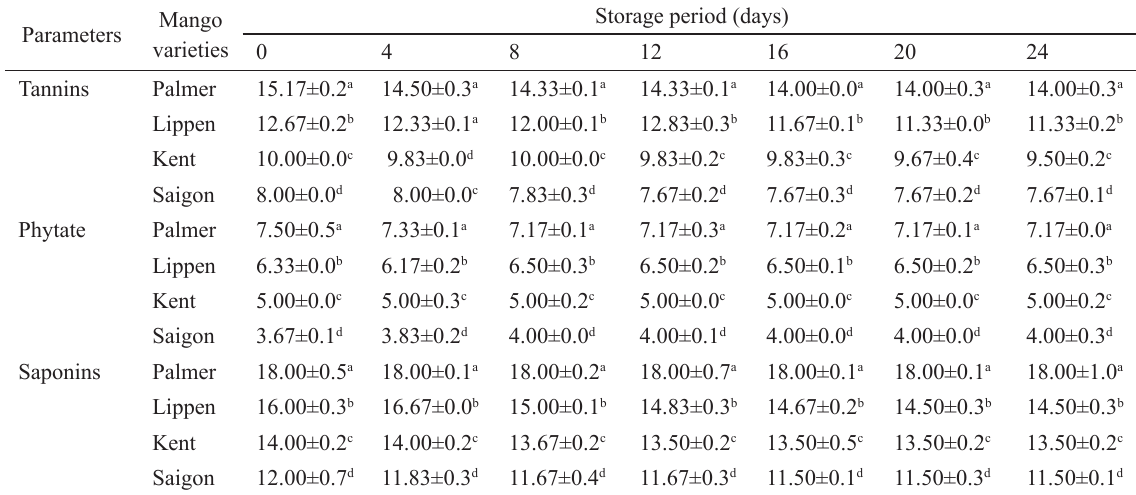
Table 4: Phytochemical properties (mg/100 ml) of juice produced from four mango varieties during storage. Parameters